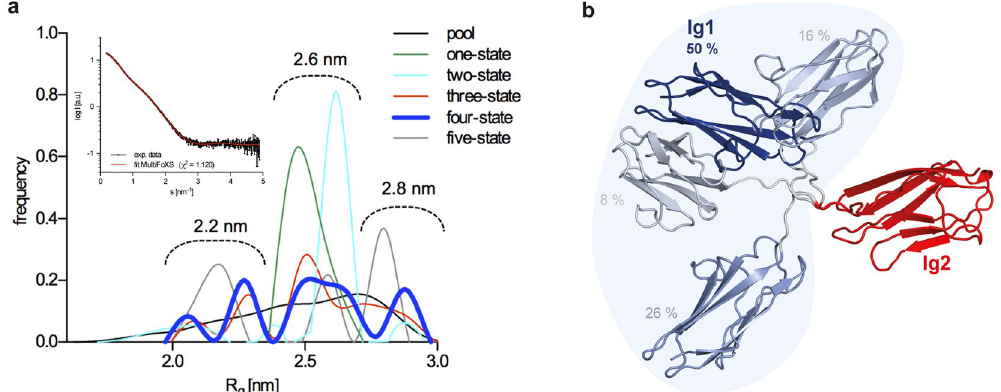
Figure 3. Flexibility assessment of the tandem Ig domains. ( a ) R g distribution plot among 100 best scoring N-state models (N = 1, 2, 3, 4, 5), where 4-state model, that best match the experimental data, is shown in bold. Convergence of the peaks from N-state models, showing three peaks with the maxima at approximately 2.2, 2.6 and 2.8 nm. Overlay of the experimental scattering data with the computed 4-state profile by the MultiFoXS flexibility approach is presented in the inset. Goodness of the fit is expressed in χ 2 ( b ) Ensemble of 4-state top best-scoring structures, superposed to the Ig domain 2 with the corresponding